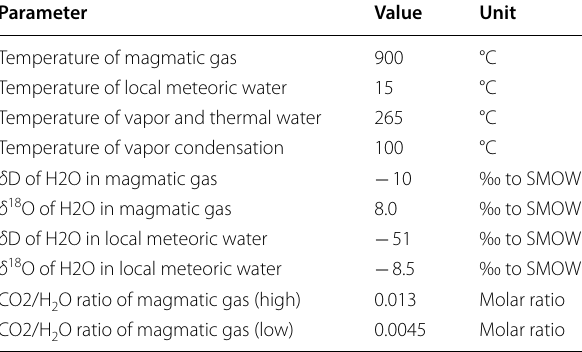
O and CO /H O 2 2 2